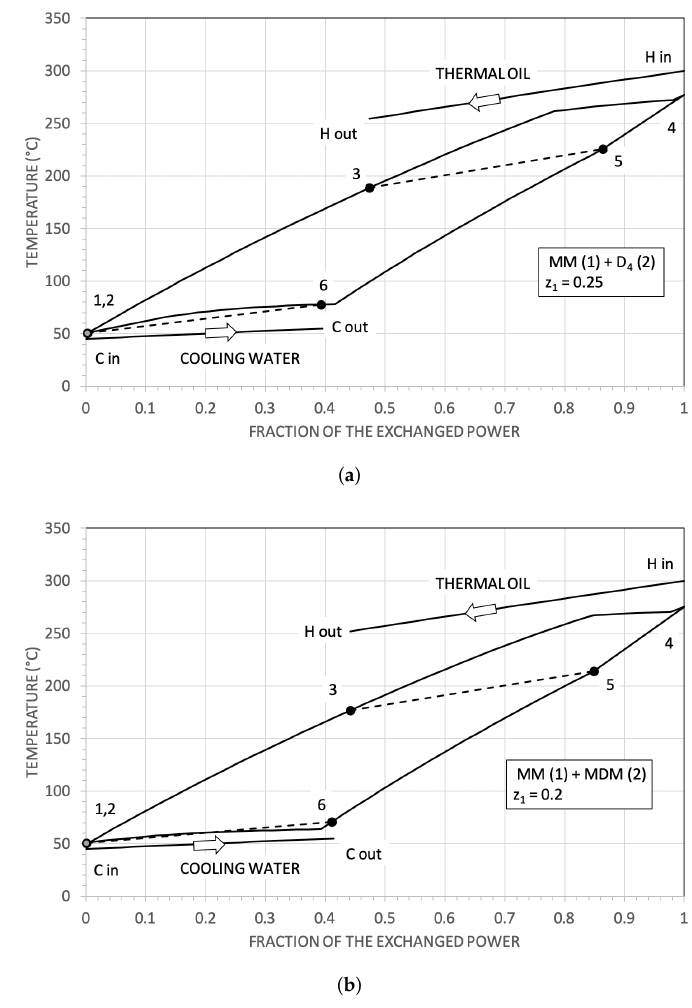
Figure 14. Two siloxane mixtures cycles, in the temperature - power exchanged plane, at optimal compositions and evaporation pressures. The design cycle parameters are shown in Table 4. In accordance with the simpler cycle configuration usually adopted, 1–2 represents the liquid compres- sion, 2–3/5–6 the recuperator, 3–4 the pre-heating and the boiling, 4–5 the expansion in turbine, and 6–1 the condensation process. ( a ) for a mixture of MM ( 1 ) + D 4 ( 2 ) at z 1 = 0.25; ( b ) for a mixture of MM ( 1 ) + MDM ( 2 ) at z 1 = 0.2. Table 5. Some cycle results. Hot oil mass flow rate: one kilo per